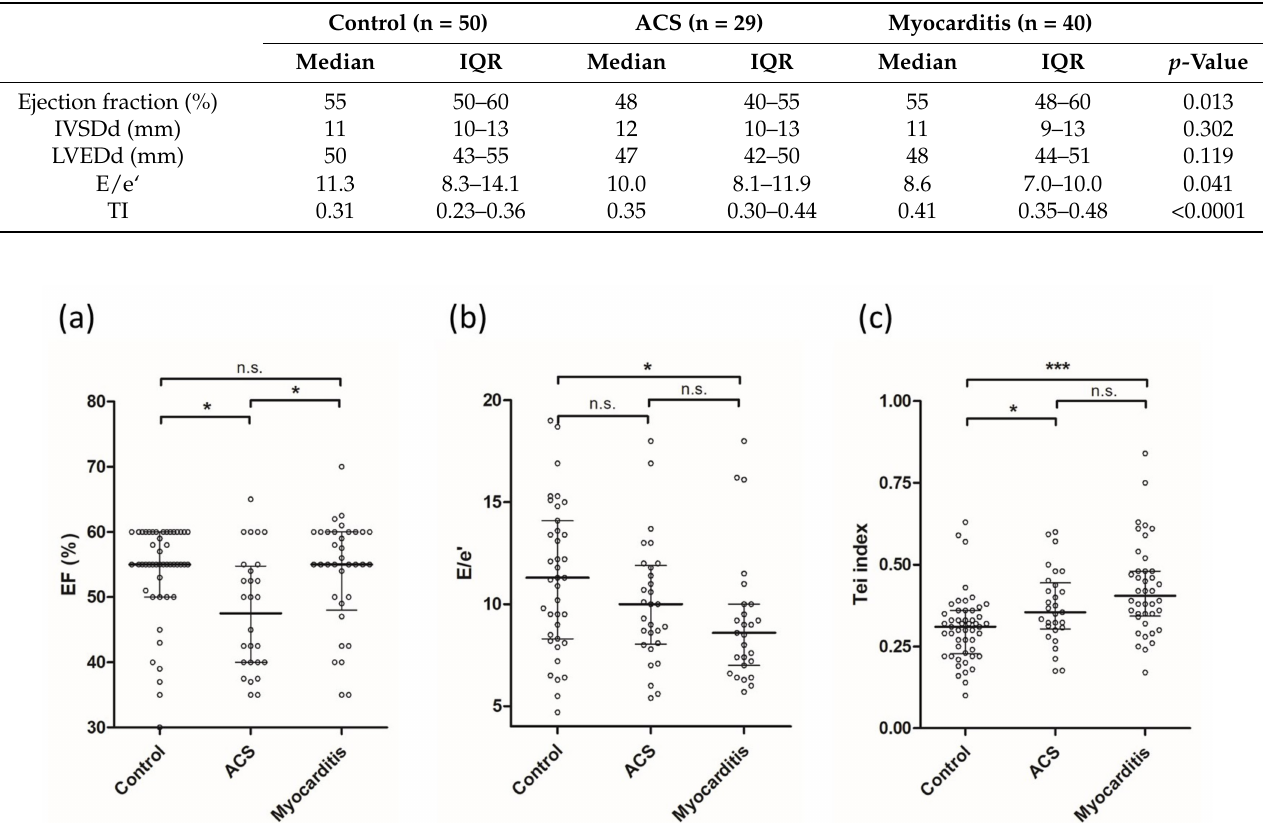
Table 2. Echocardiographic parameters. Abbreviations: IQR = interquartile range, IVSDd = inter- ventricular septum thickness in diastole, LVEDd = left ventricular end-diastolic diameter in diastole,